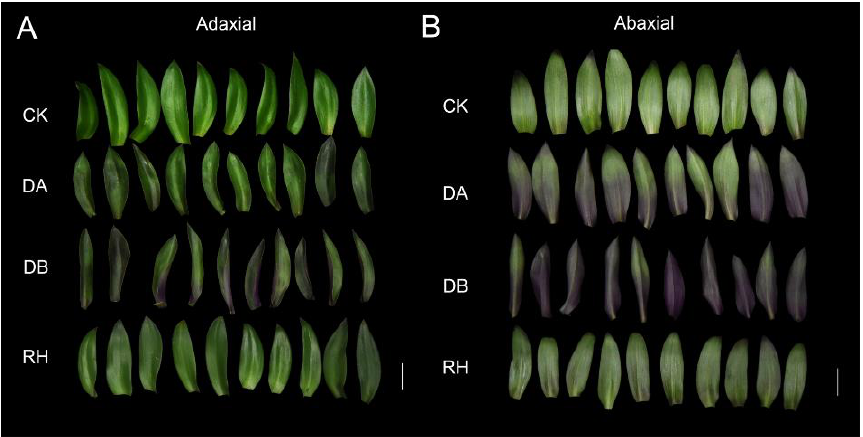
Figure 1. Phenotypic comparison of B. ciliata ‘Qiuhong’ leaves with or without drought treatments. ( A ) Adaxial blade leaves under the different treatments (Control, CK; 15-day drought treatment, DA; 30-day drought treatment, DB; rehydration after DB, RH). ( B ) Abaxial blade leaves under the different treatments of CK, DA, DB, and RH. Scale bars = 1 cm.